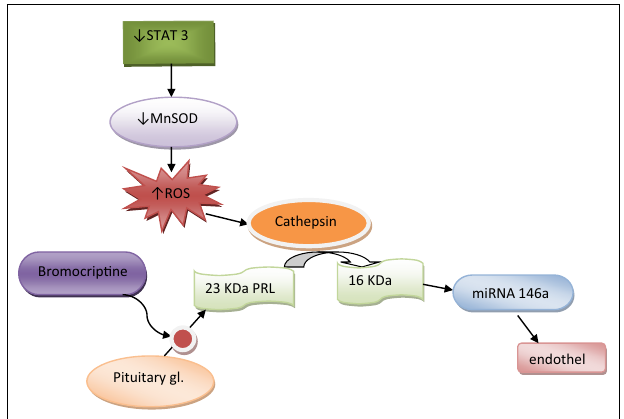
FIGURE 1 | Pathogenesis of peripartum cardiomyopathy